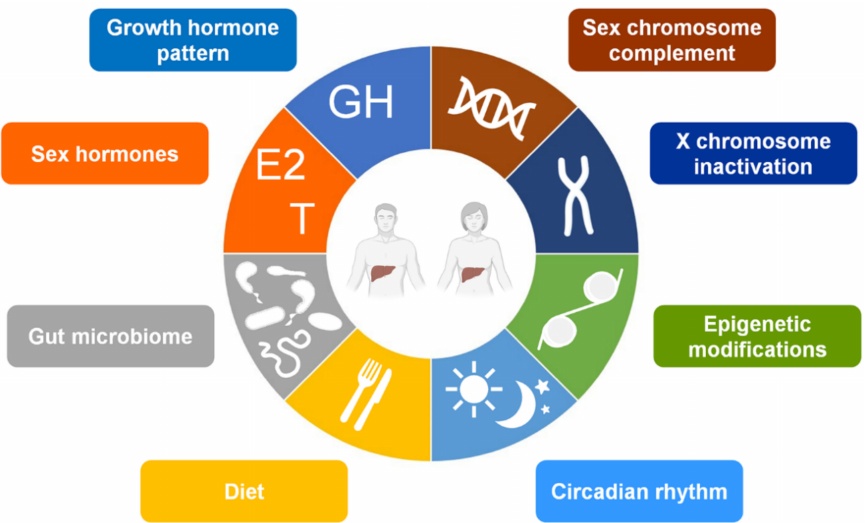
Figure 1. Main factors contributing to the hepatic sexual dimorphism. Abbreviations: E2, 17 β - estradiol; GH, growth hormone; T,